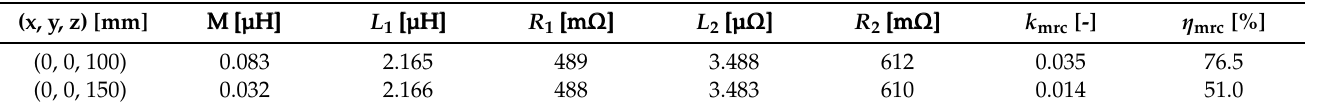
Table 3. Calculated link efficiency using simulation data obtained via the finite element analysis for two vertical